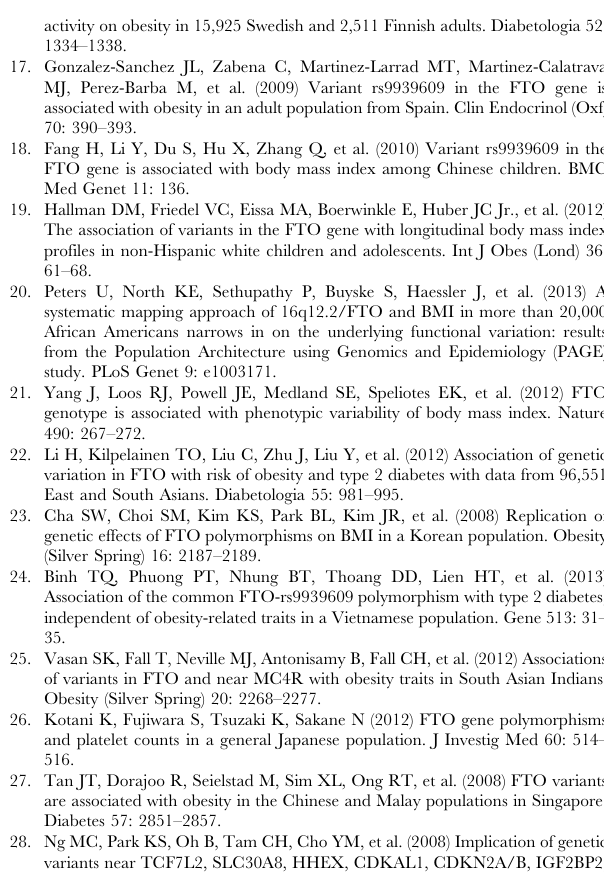
Table S1 BMI thresholds (Kg/m 2 ) of the 15 th , 85 th , 95